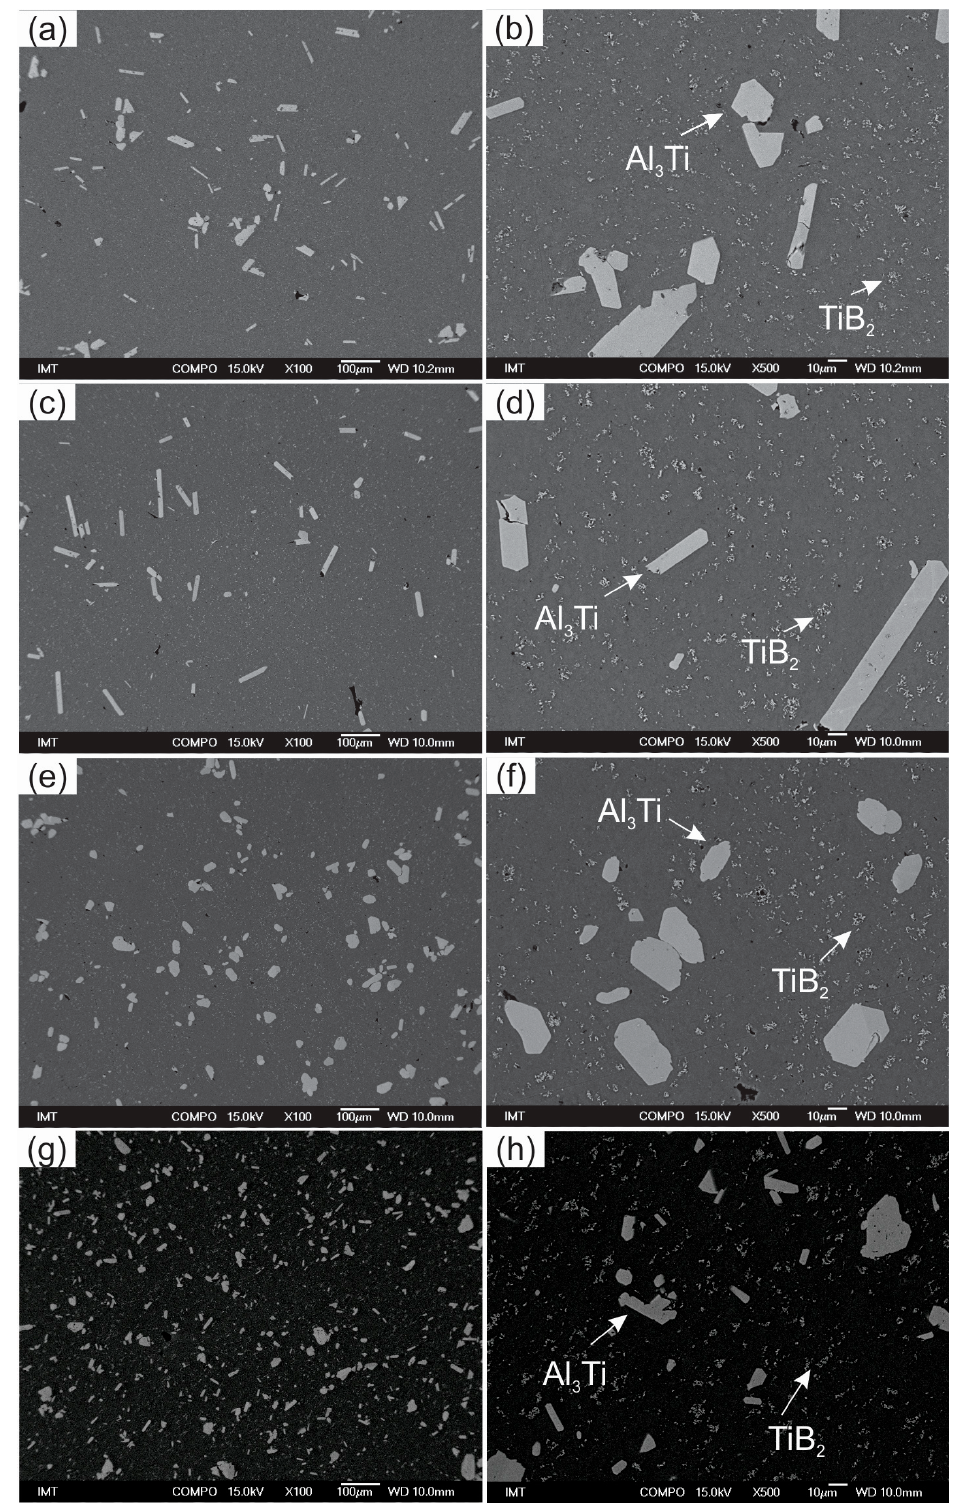
Figure 3. SEM images of investigated grain re fi ners: ( a , b ) A, ( c , d ) B, ( e , f ) C, and ( g , h ) D.